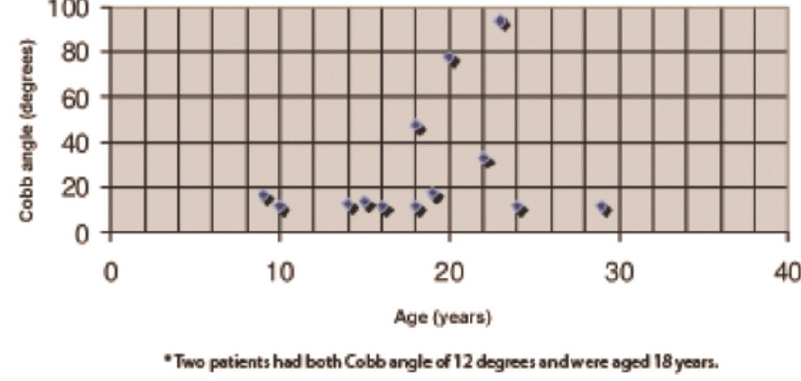
Figure 2 - Cobb angle in the scoliosis main curve in Williams-Beuren syndrome patients according to